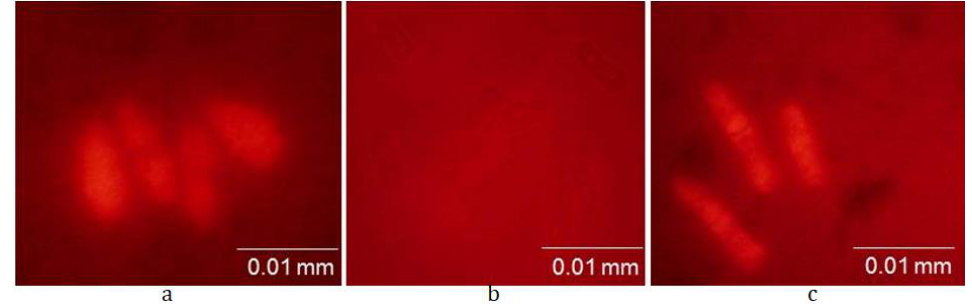
Figure 9. Effect of Xyloccensins K on mitochondrial activity of yeast S. pombe : (a) EMM 0.5% of glucose (control +, 0µg.mL -1 ), (b) YES 3% of glucose (control -, 0µg.mL -1 ), (c) YES 3% of glucose + 25µg.mL -1 of Xyloccensins K. Bar in each picture represents 10µm scale.